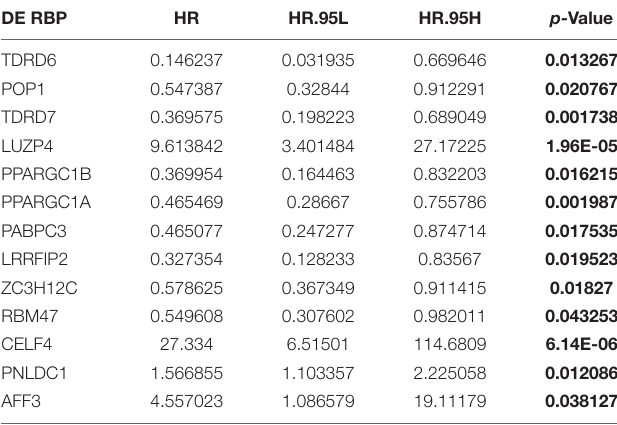
TABLE 1 | Univariate Cox proportional hazards regression analysis of DE